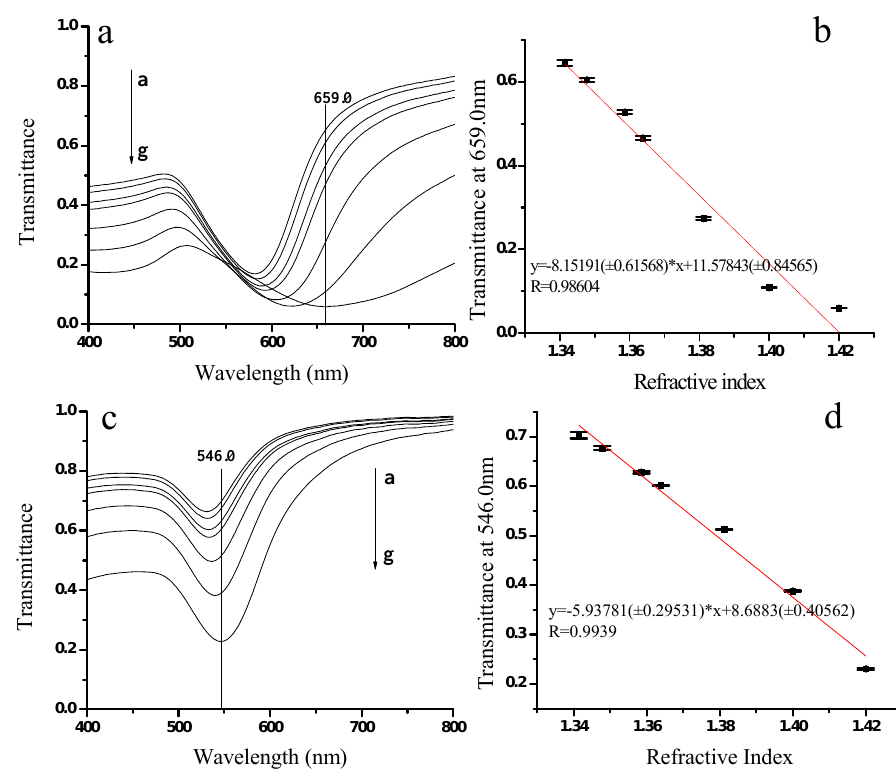
Figure 4. (a) and (c) The transmission spectra of different concentrations of sucrose solution by using the 48-nm and 23-nm Au NP films, respectively. a-g are from low to high concentrations. (b) The transmission at 659.07 nm of 48-nm Au as a function of the refractive index of sucrose solutions. (d) The transmission at 546.0 nm of 23-nm Au as a function of the refractive index of sucrose